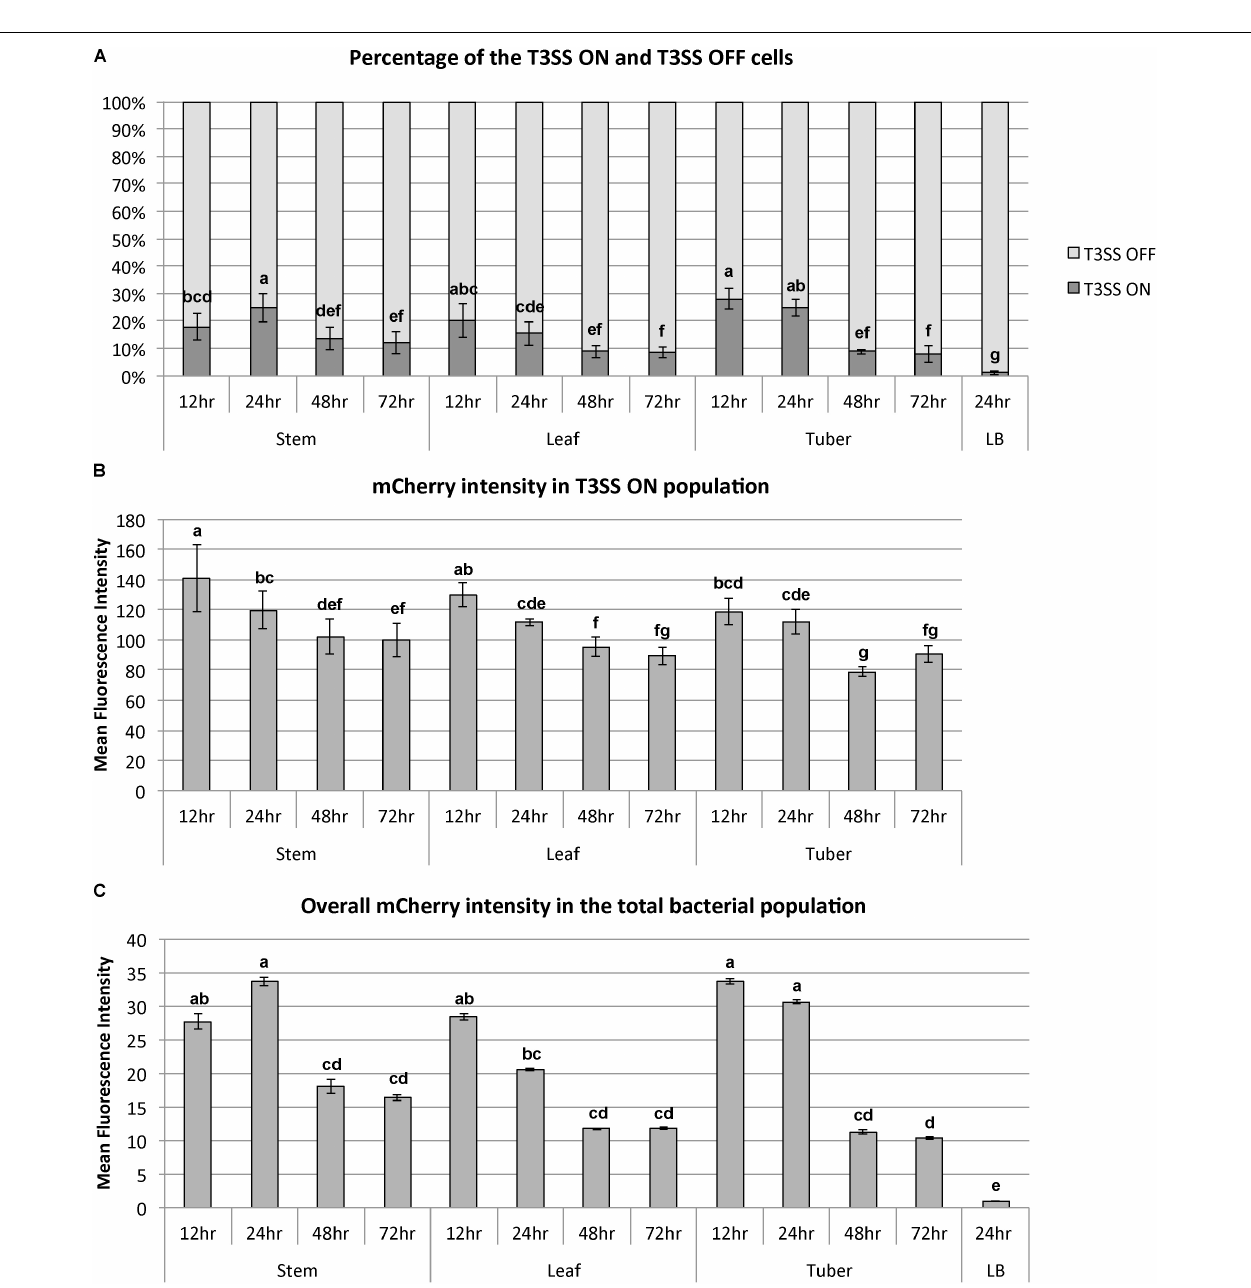
FIGURE 4 | Dynamics of bi-stable expression of hrpN in D. dadantii during the disease progression in stem, leaf, and tuber of potato. D. dadantii carrying the dual fluorescence reporter nptII-gfp-hrpN-mCherry was inoculated into stem, leaf, and tuber. Symptomatic tissues were collected at 12, 24, 48, and 72 h post inoculation and were examined by flow cytometry. (A) Percentage of cells that highly express hrpN (T3SS ON cells) and do not express hrpN (T3SS OFF cells), as defined by gates used in Figure 3 . (B) Expression level of hrpN in the T3SS ON cells, indicated by the fluorescence intensity of mCherry. (C) Overall expression level of hrpN in the total population, indicated by the fluorescence intensity of mCherry. Five biological replicates were included. Statistic analysis was performed using the one-way analysis of variance (ANOVA) model in the “stats” package in R. The presence of different letters indicates significant difference at P <